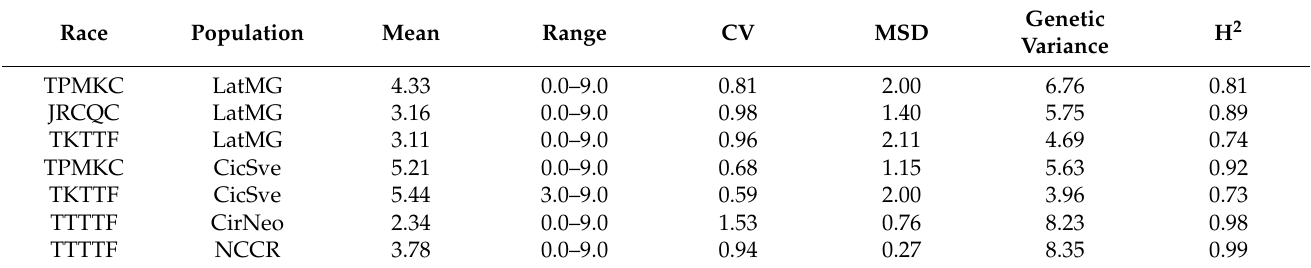
Table 2. Statistic parameters for reaction of the mapping populations to four races of Puccinia graminis f. sp. tritici . CV: coefficient of variation; MSD: minimum significant difference; H 2 : heritability.